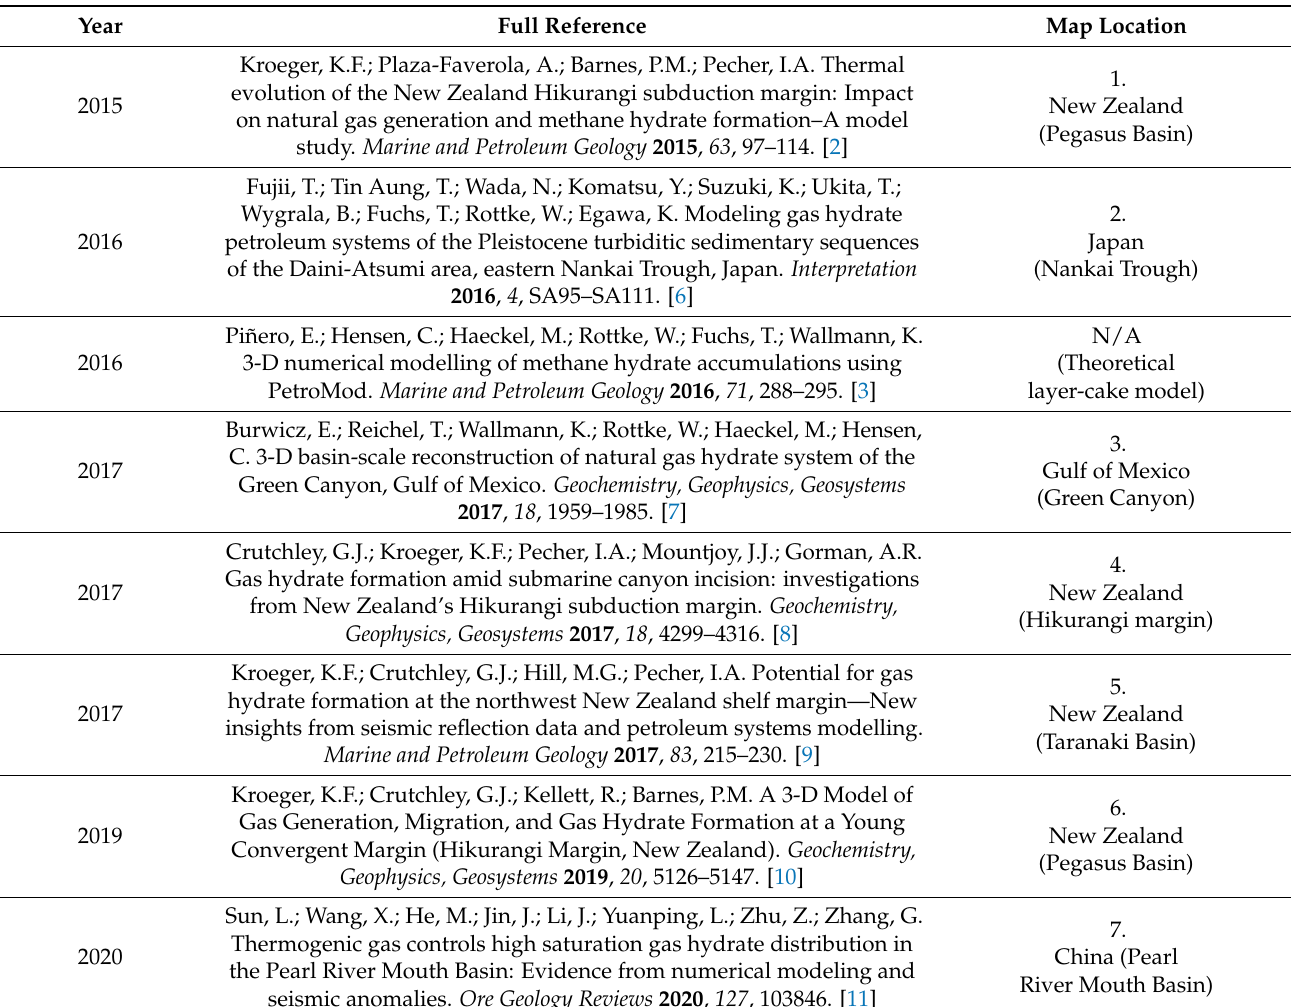
Table 1. Basic metadata of the modelling studies surveyed that use TOC and/or HI values.